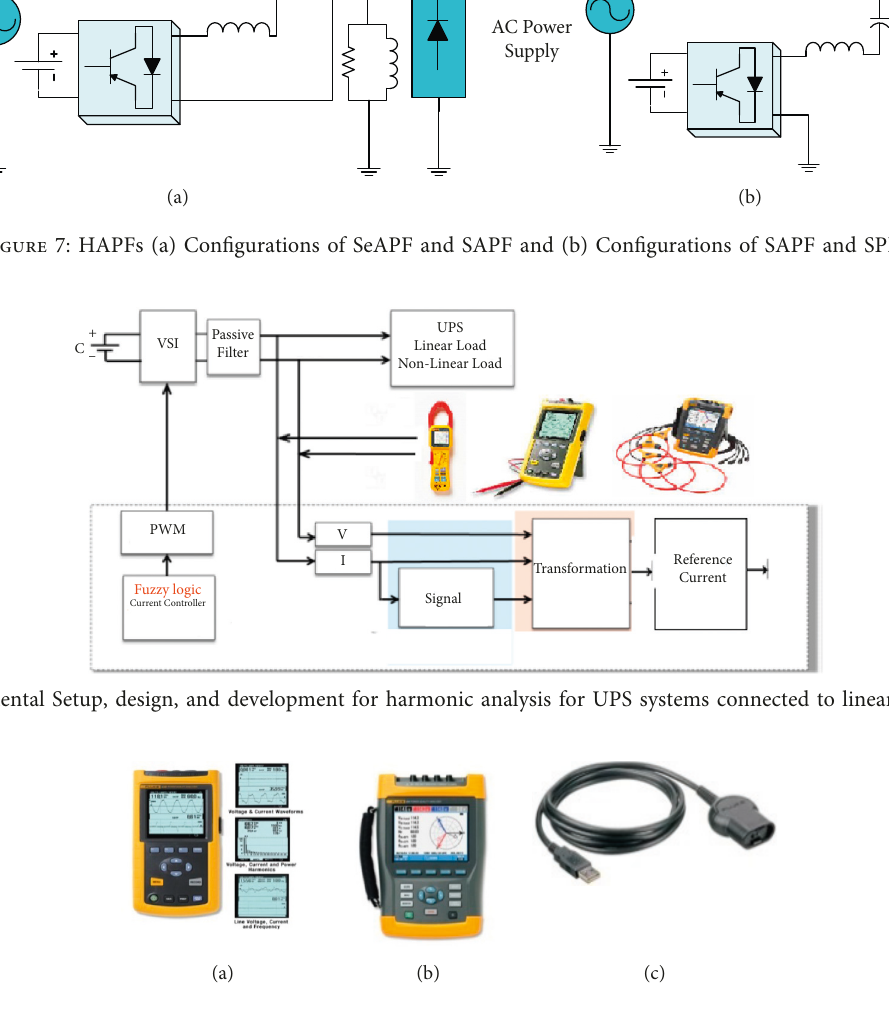
Figure 9: (a-c) PQ & EA fluke Analyzer 435-43b and Optical USB Interface Cable (OC4-USB) for Experimental Harmonic Analysis. Table 1: Different UPS System Efficiency and THD Result from experimental